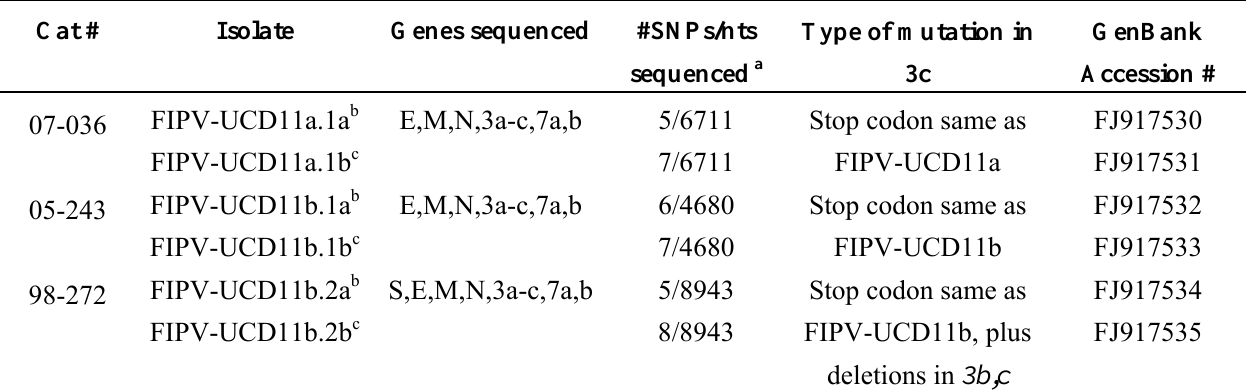
Table 4. Name and biotype designation of coronavirus isolates from three cats dying of experimentally induced FIP. The genes that were sequenced, their mutability, degree of relatedness to the consensus sequence of FIPV-UCD11a, b, and nature of the functional mutation in the 3c gene are given for each